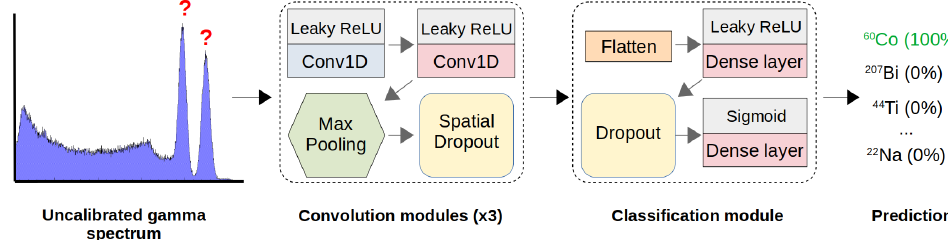
Figure 3. Simplified CNN structure for radio-isotope identification. The sequential model consists of several convolution modules, each performing 1D convolution operations to extract relevant features. For classifications, the resulting tensor is flattened into a vector to interface with a small, fully-connected ANN. The final output layer provides the probability of each source being present in a gamma spectrum.